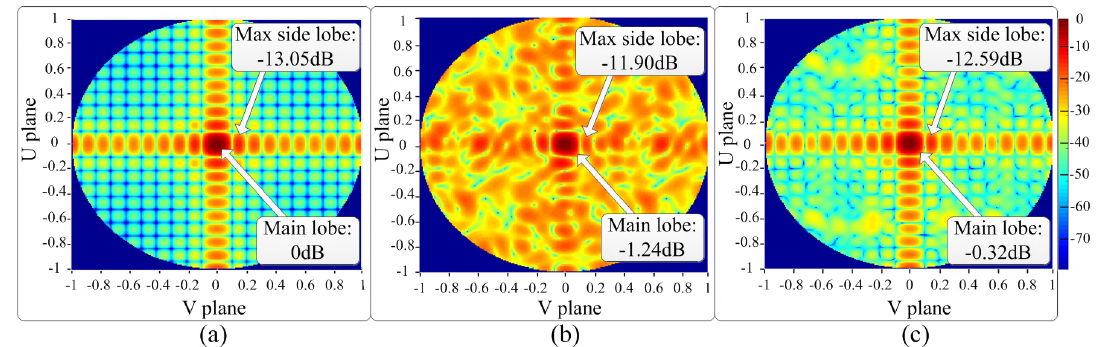
Figure 17. The contour plots of the radiation pattern of a planar array with 12 × 12 antennas. The main beam locates at the center of every plot. The relative power intensity is indicated by different colors. ( a ) The radiation pattern without any amplitude and phase errors. ( b ) The radiation pattern with antenna amplitude and phase errors. ( c ) The radiation pattern calibrated by the proposed method. SIR = 14